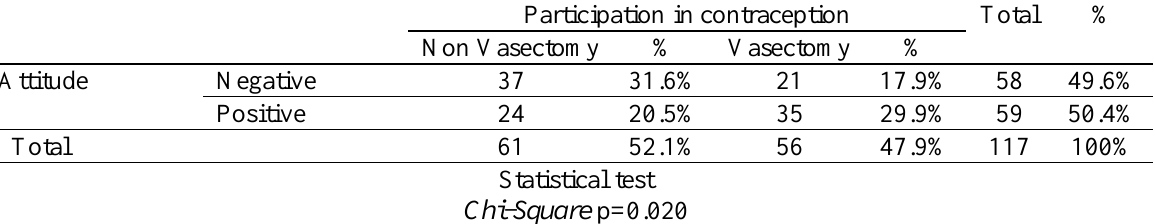
Table 2 The correlation of attitude and vasectomy selection using a Chi-Square Test